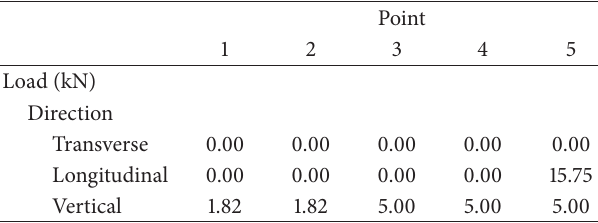
Table 5: Experimental conductor breakage loading for tower studied.